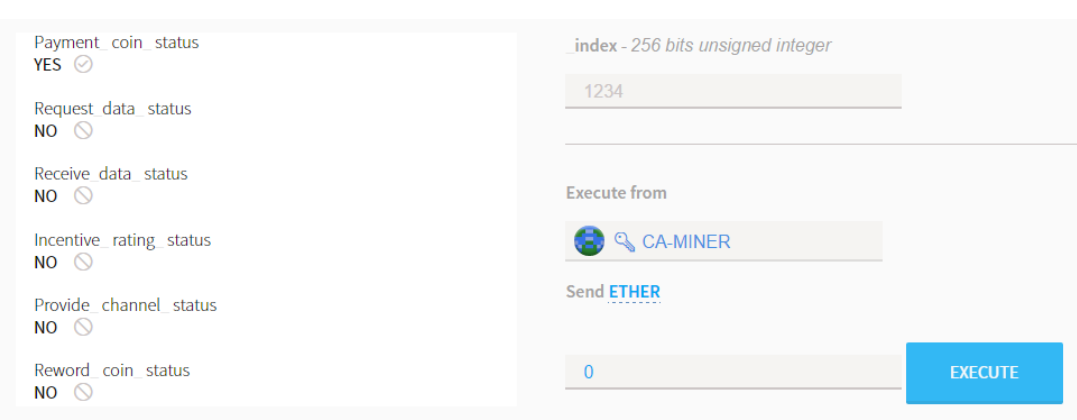
Figure 7. The status change at the start of a smart contract in Mist-Browser.